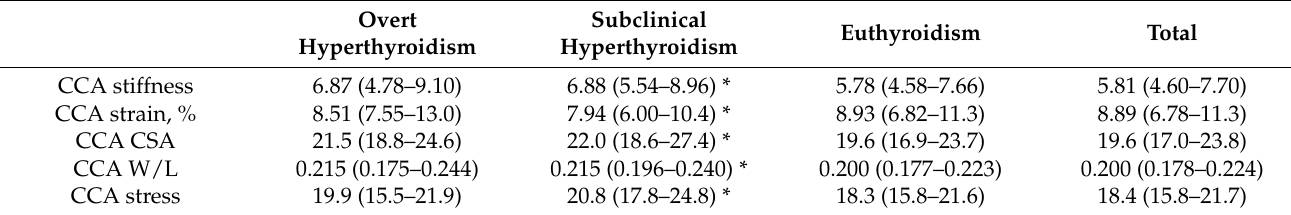
Table 2 shows cardiovascular parameters at the right common carotid level. Subjects with subclinical hyperthyroidism had a higher stiffness index, circumferential stress area (CSA), and circumferential stress and lower strain ( p < 0.001 for all). Subjects with overt hyperthyroidism had higher wall–lumen ratios as compared to euthyroid, although this was not statistically significant. Table 2. Effect of thyroid status on common carotid structure. Overt